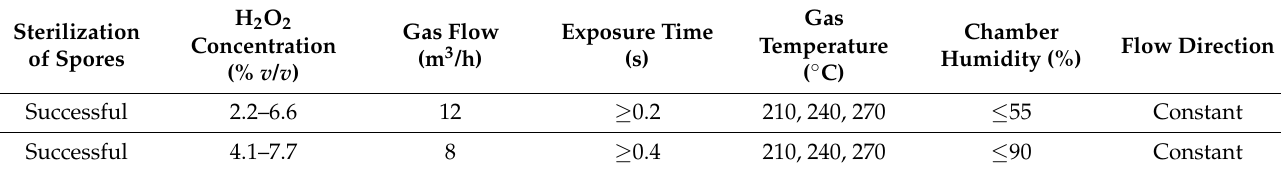
Table 3. A qualitative assessment of the correlations between the sterilization process